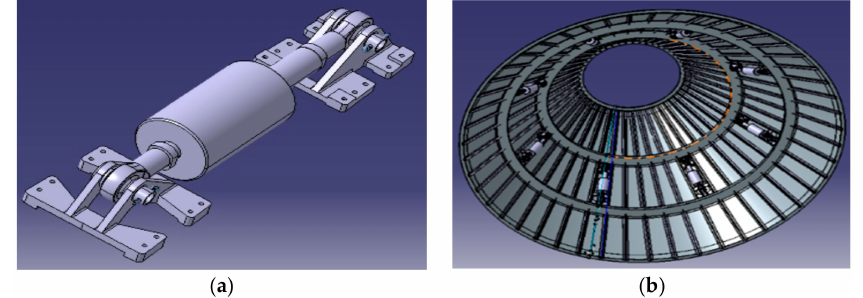
Figure 13. Three-dimensional model: ( a ) one set of dampers; ( b ) PAF with the damping